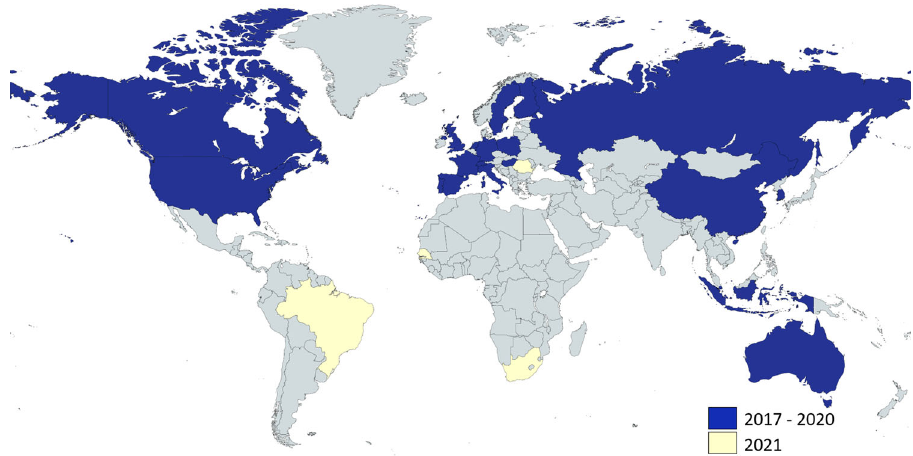
Fig. 1 Global distribution of laboratories participating in RefBio. Highlighted in blue are laboratories from UN Member States already involved, highlighted in yellow are laboratories interested in future participation. The fi gure was created with mapchart.net licensed under a Creative Commons Attribution- ShareAlike 4.0 International